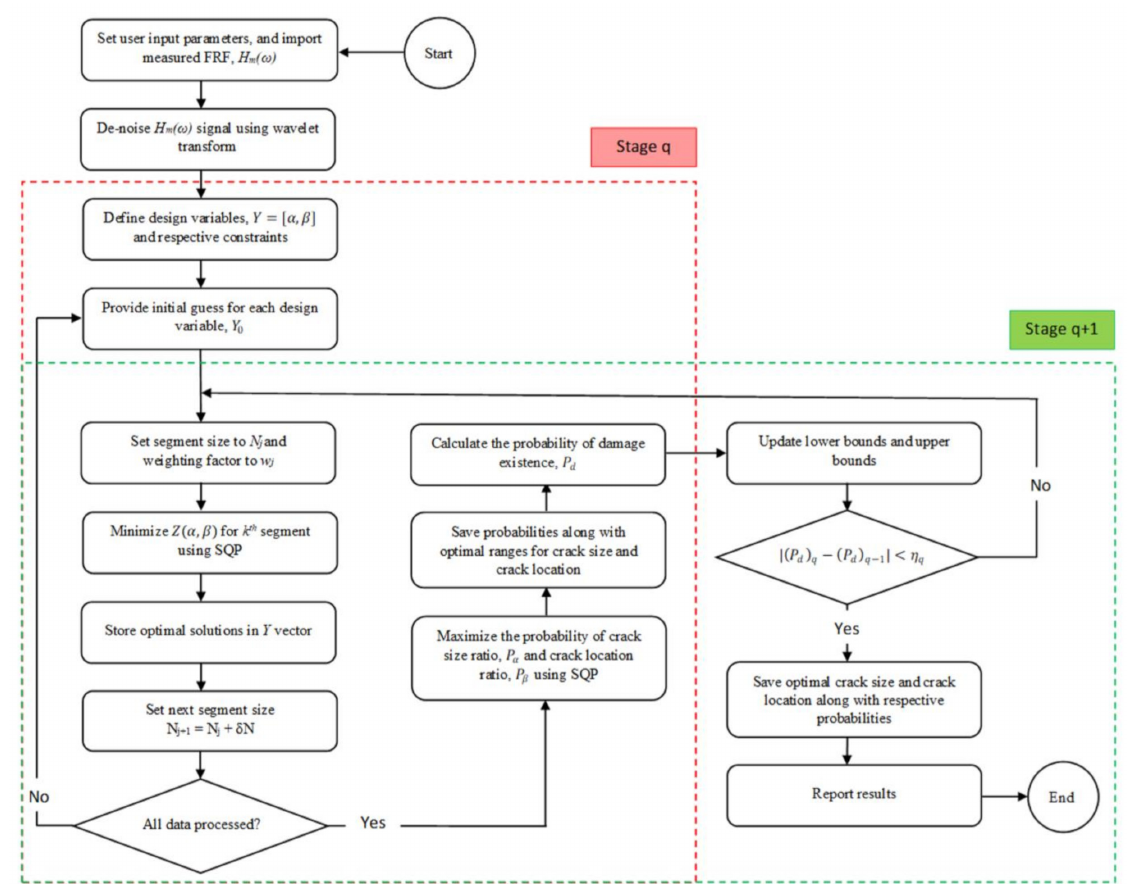
Figure 1. Flowchart for the adaptive multi-stage